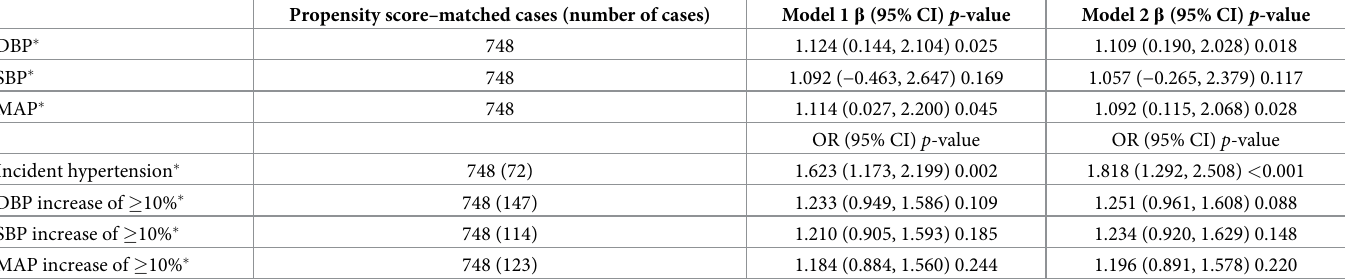
Table 6. Effect of moving to residences of lower liveable area (in reference to propensity-matched nonmovers) upon incident hypertension and blood pressure out- comes at wave 2. Propensity score–matched cases (number of